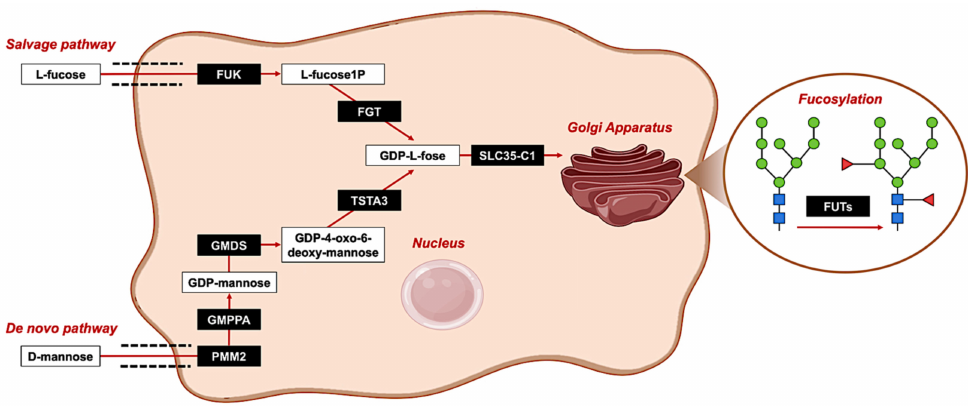
Figure 1. Fucose biosynthetic cellular pathways. The representative figure depicts fucose biosynthetic pathways, namely the salvage pathway ( top ) and the de novo pathway ( bottom ). On the one hand, 90% of GDP-L-fucose biosynthesis derives from the de novo pathway : D-mannose is processed by GDP- mannose-phosphorylase A (GMPPA), GDP-mannose 4,6-dehydratase (GMDS) and tissue-specific transplantation antigen p35B (TSTA3). On the other hand, 10% of GDP-L-fucose biosynthesis derives from the salvage pathway , in which free fucose derived from dietary intake is recycled by fucose kinase (FUK) and fucose-1-phosphate guanylyltransferase (FPGT). Then, the newly synthesized GDP-L- fucose is carried from the cytoplasm to the Golgi apparatus by the specific transporter SLC35C1. It is finally within the Golgi that GDP-L-fucose is conjugated to glycopeptides by highly specialized enzymes called FUTs. Abbreviations: PMM2: phosphomannomutase 2; GMPPA: